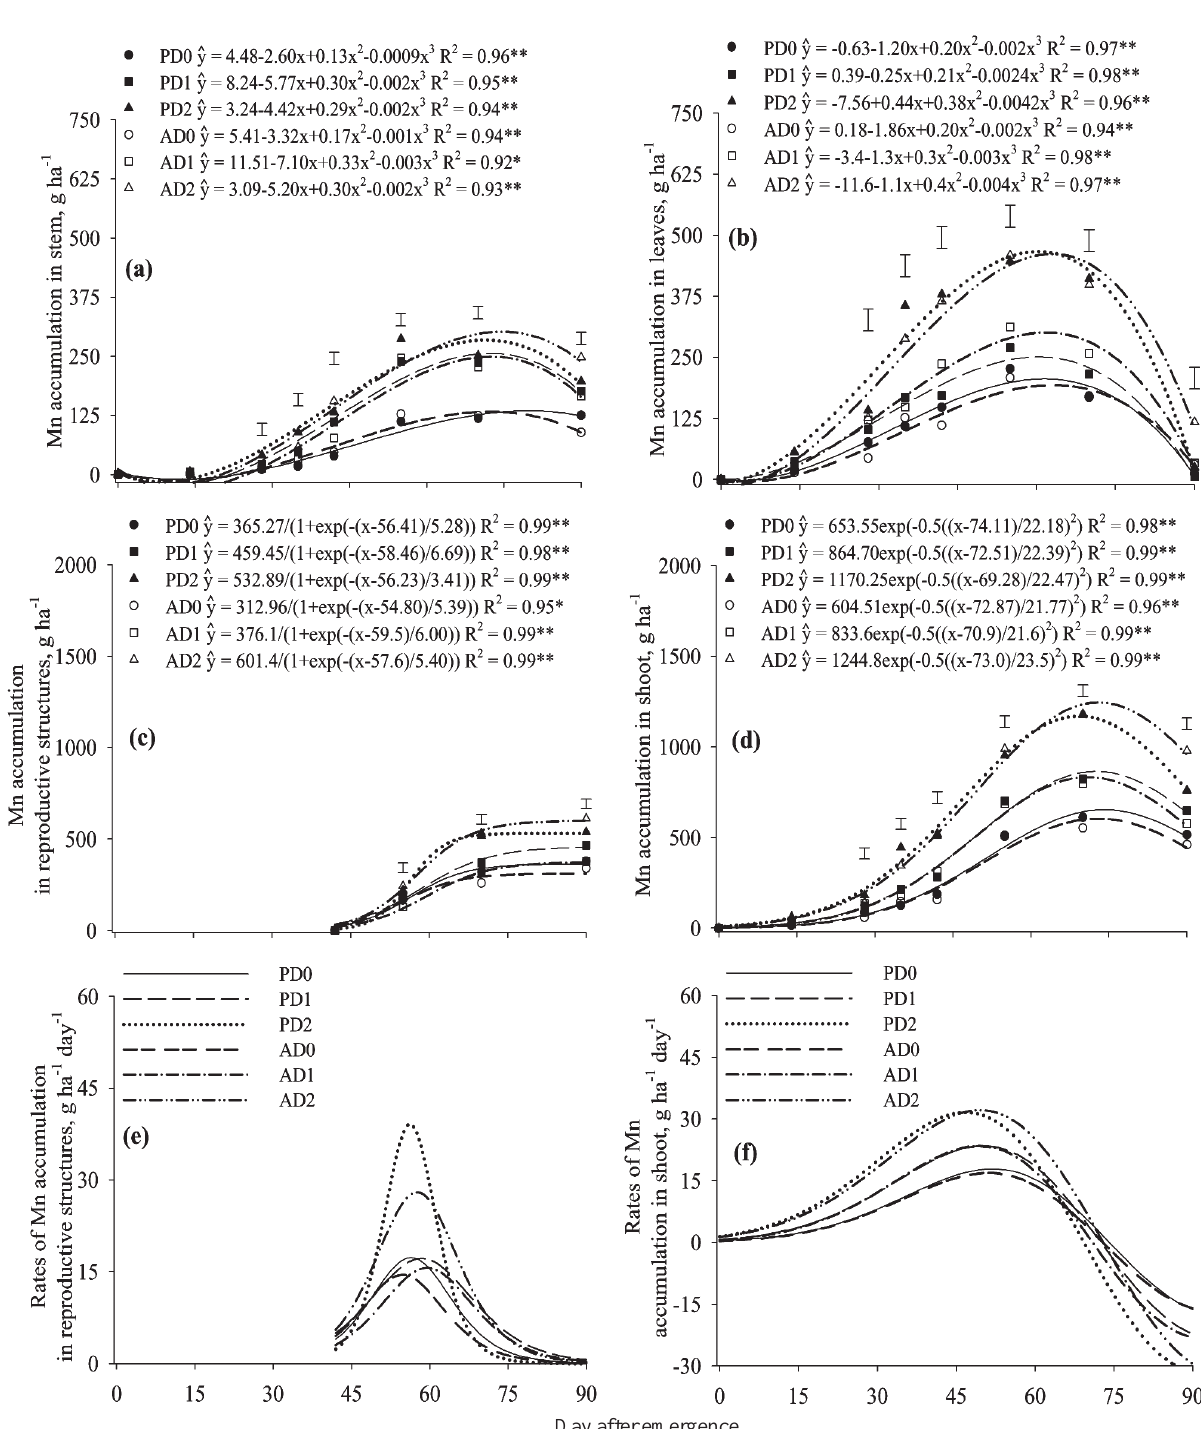
Figure 4. Manganese accumulationin stem (a), leaves (b), reproductive structures (c), and shoot (d) and rates of accumulation of Mn in reproductive structures (e) and shoot (f) of common bean cultivars, under different levels of fertilization. ** and * are: significant at p 0.01 and p 0.05 by the F test. Vertical bars represent the Least Significant Difference (LSD) at p 0.05. PD0 = Pérola without NPK fertilization, PD1 = Pérola with 50 % of recommended NPK fertilization; PD2 = Pérola with 100 % of recommended NPK fertilization; AD0 = IAC Alvorada without NPK fertilization, AD1 = IAC Alvorada with 50 % of recommended NPK fertilization; AD2 = IAC Alvorada with 100 % of recommended NPK